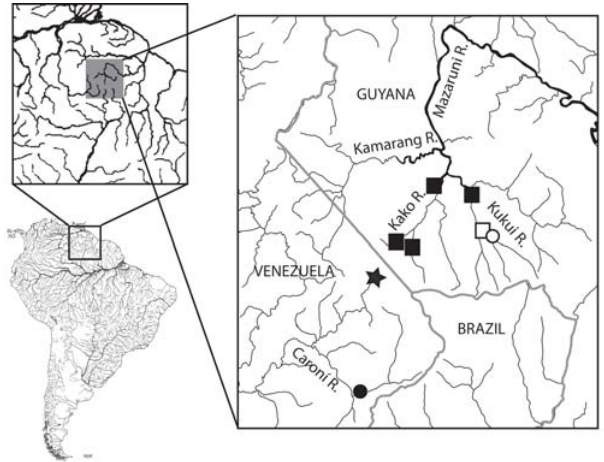
Fig. 2. Distribution of Neblinichthys species in the Caroní and Mazaruni basins of Venezuela and Guyana, respectively. Star = N . roraima , black circle = N . yaravi , empty circle = type-locality of N . echinasus , new species, empty square = type-locality and black squares = paratype localities of N . brevibracchium , new